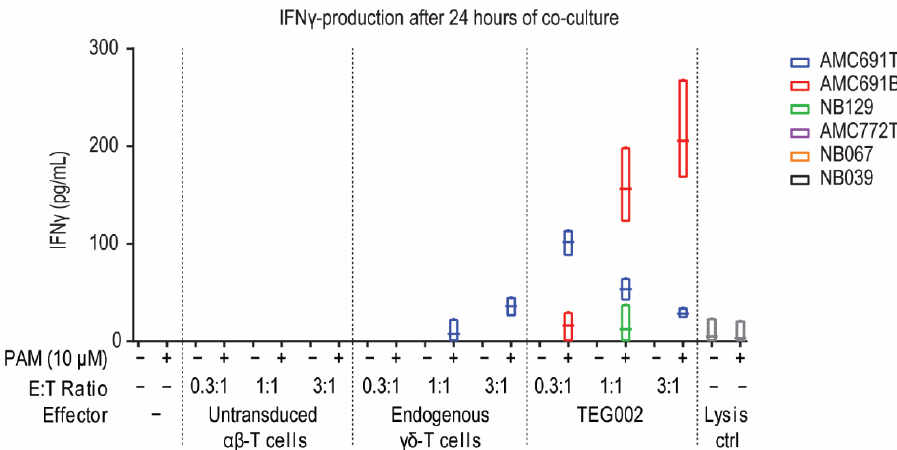
Figure 2. IFN γ concentration in supernatant of co-cultures reflecting effector activation. Supernatant of the co-cultures was taken at 24 h and measured by ELISA. Data are only shown when at least one of the data points was higher than 0. Grey for lysis control shows average of all organoids. Line in boxplot indicates the mean. Lysis control is puromycin (1 µ g/mL). PAM = Pamidronate; E:T = Effector to Target; n = 3.